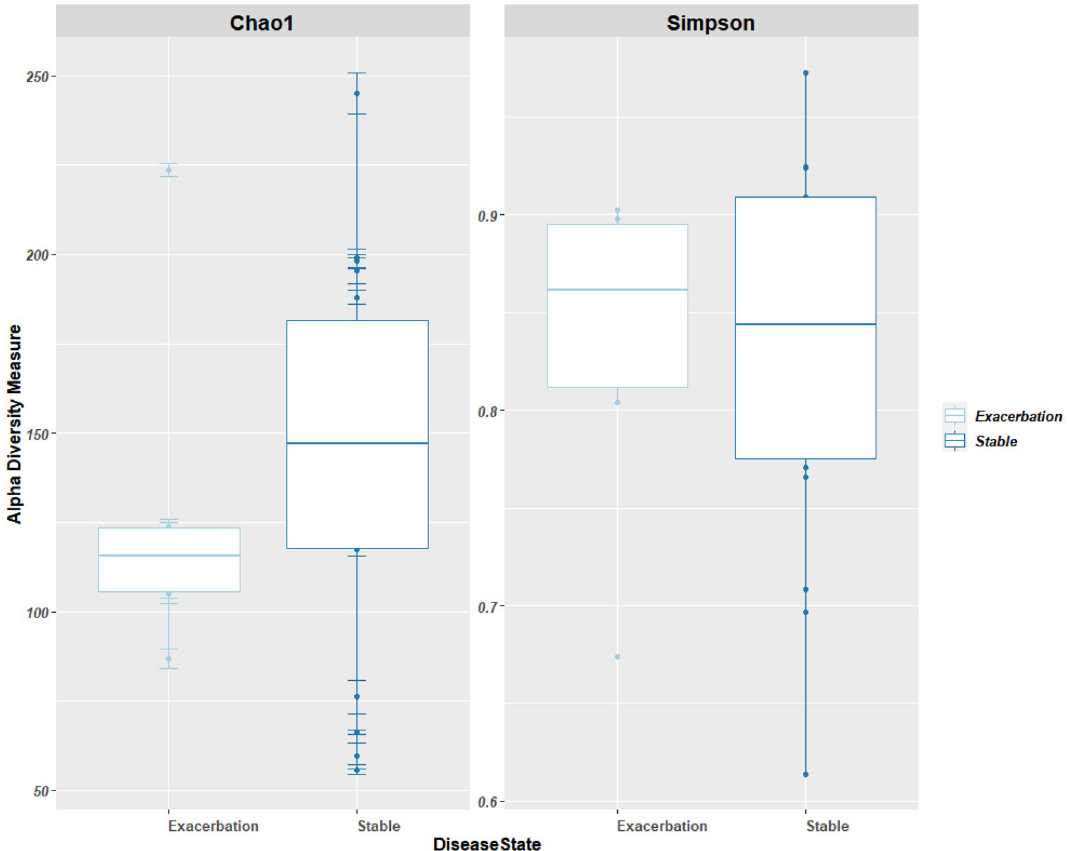
Figure 3. The alpha diversity box-plot of the sputum microbiome compared across the exacerbated state (n = 6) and stable state (n = 18) of COPD using Chao1 and Simpson diversity measures. Each dot on the graph represents a sample. The boxes represent the interquartile range (IQR) and the horizontal line represents the median. The median values for Chao1 diversity measure were as follows: (i) stable state = 147.06 and (ii) exacerbated state = 115.56. The median values for the Simpson diversity measures were as follows: (i) stable state = 0.84 and (ii) exacerbated state =